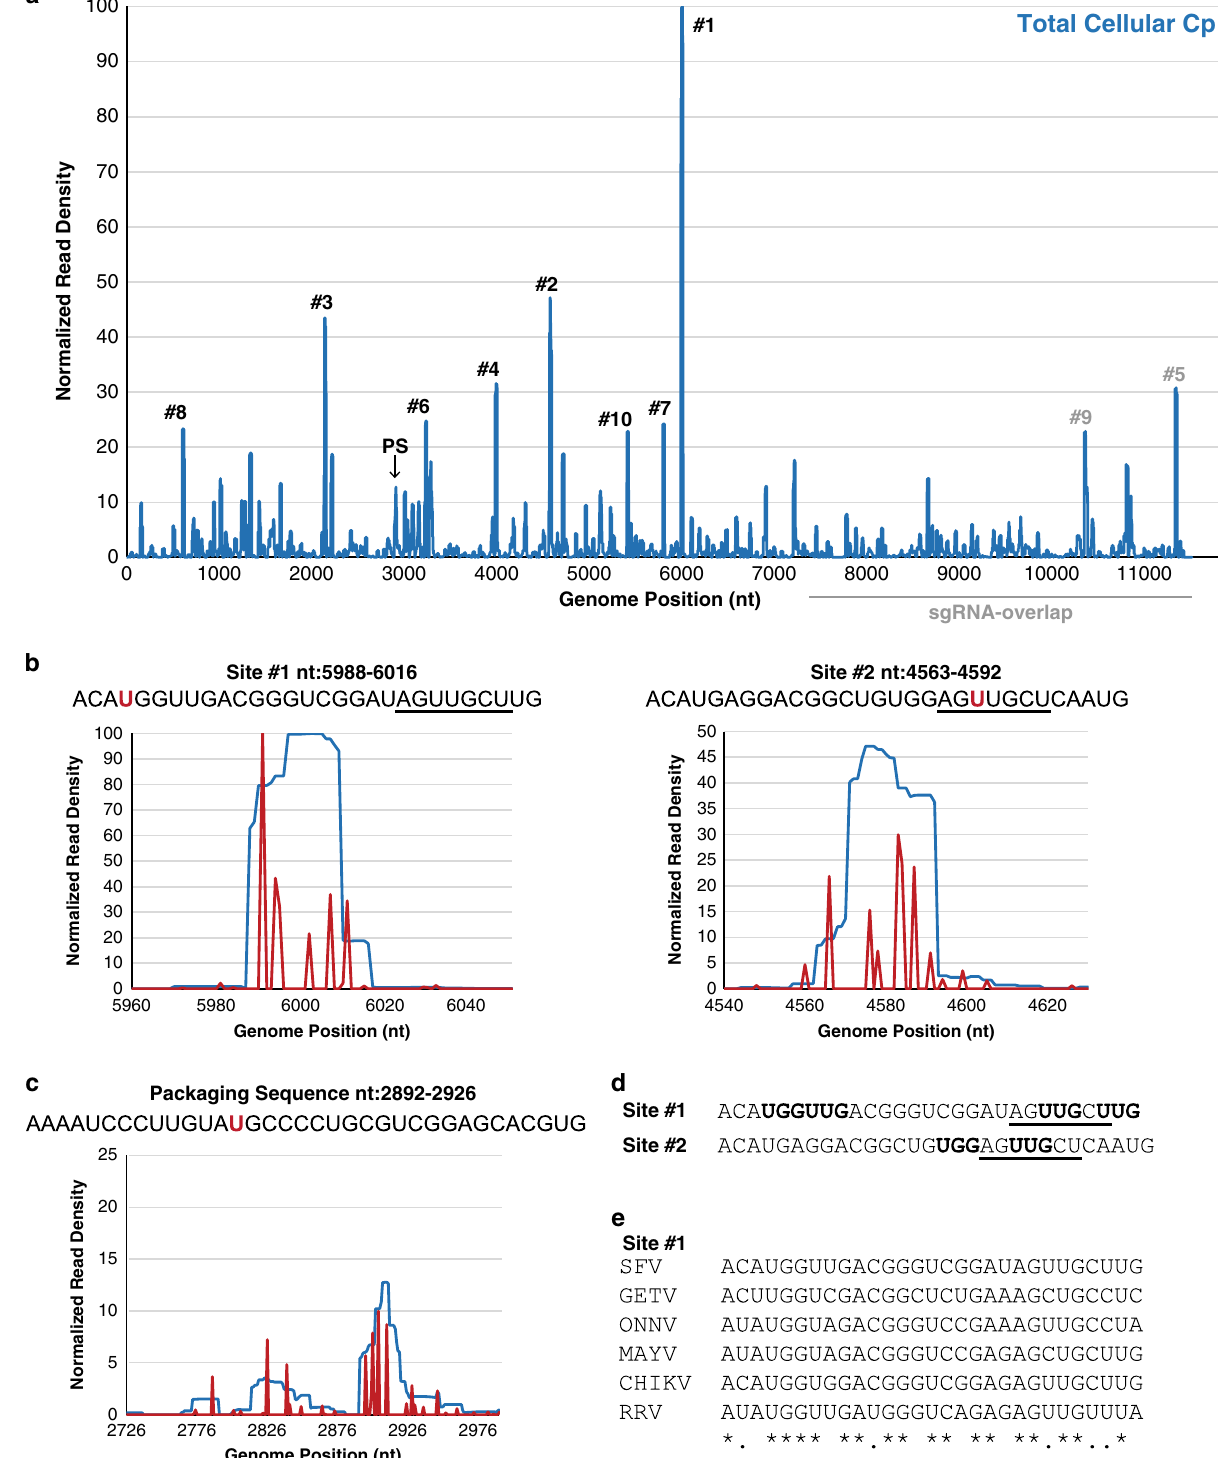
233,188 sequence reads, respectively, that contained the diag- nostic T-to-C mutation introduced during cDNA library construction of 4SU-labeled and crosslinked RNA. This allowed us to (a) remove background sequences from co-purifying, non- crosslinked fragments from abundant RNAs and (b) identify the crosslinking site at nucleotide resolution. Comparison of the crosslinked sequence reads revealed an excellent correlation for